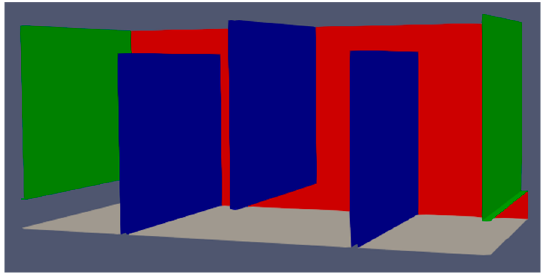
Figure 5. Contact tank baffle configuration for baffles without slots.